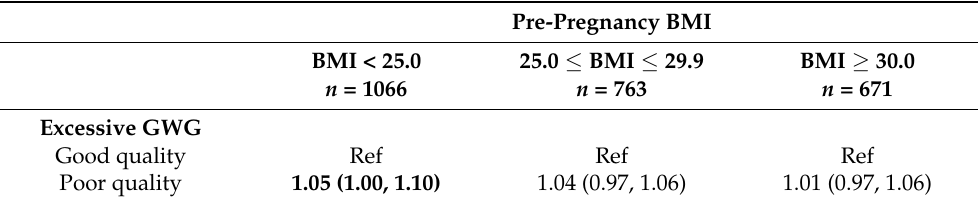
Table 3. Adjusted * relative risk of excessive gestational weight gain rate by diet quality defined by HEI-2010, stratified by pre-pregnancy